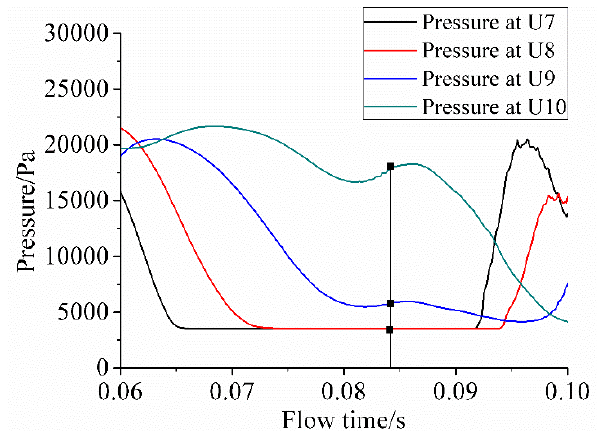
Figure 19. Pressure pulsation at U7, U8, U9, and U10 for σ = 0.65.